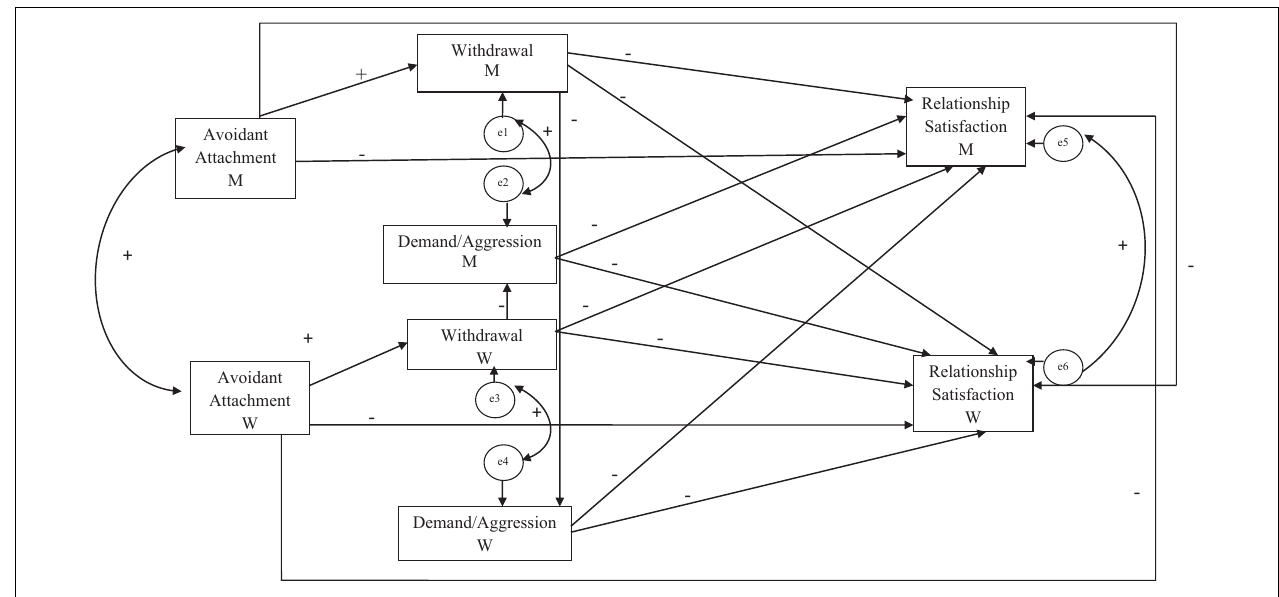
FIGURE 1 | Hypothesized model.